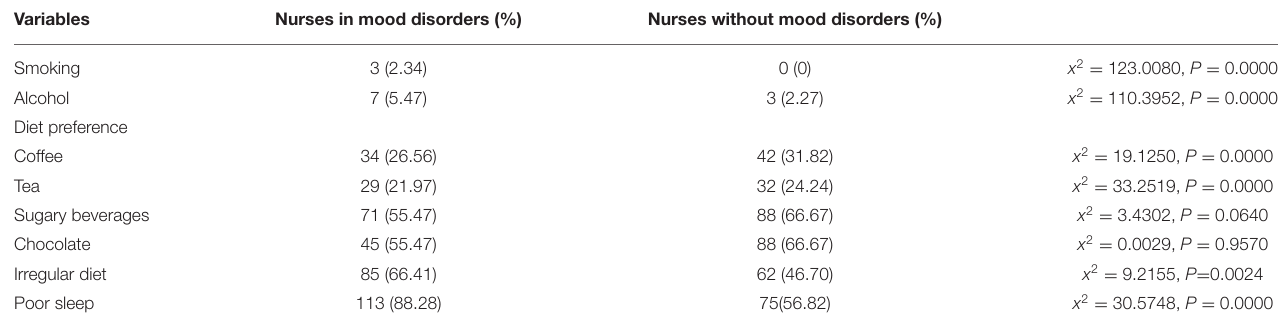
TABLE 3 | Lifestyles among neonatal nurses in mood